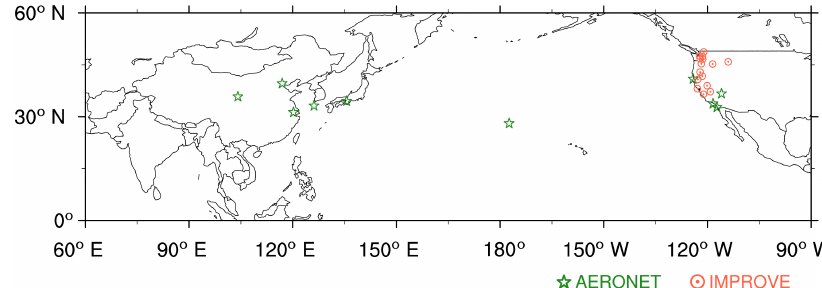
Figure 1. Observation sites for the AERONET (green stars) and IMPROVE (red-dotted circles) networks used in this study.